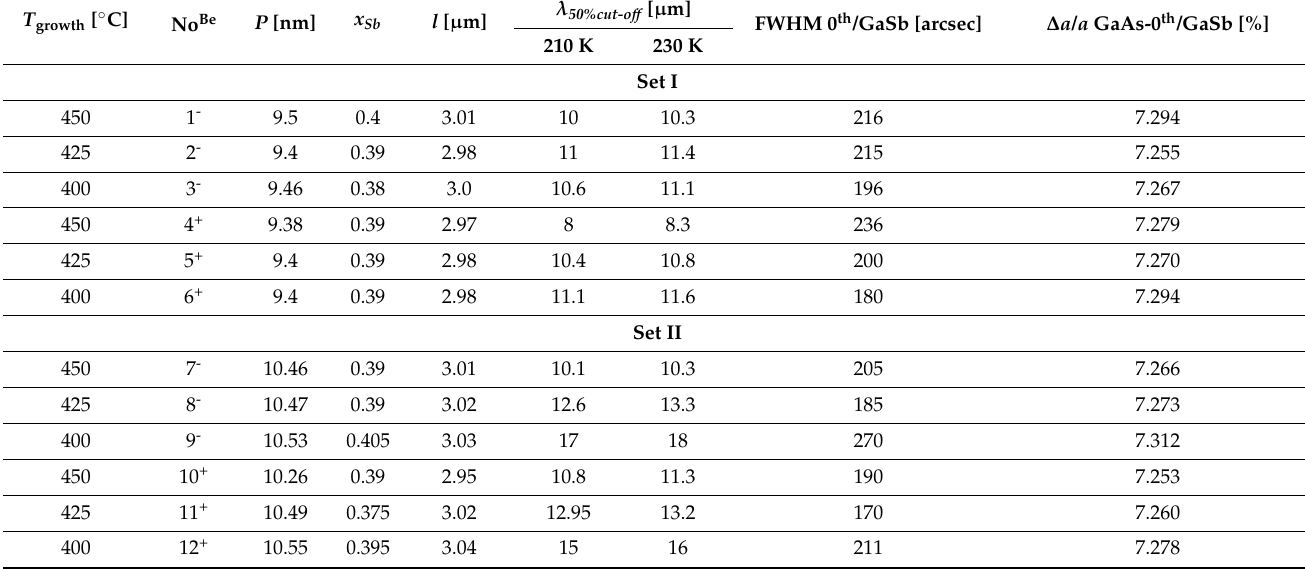
Table 1. MBE growth temperatures, analyzed T2SL structure properties (period, Sb composition), T2SLs’ active layer thickness, and measured λ 50%cut-off at 210, 230 K, FWHM for 0 th -order HRXRD peaks of theT2SLs/GaSb and lattice mismatch ∆ a/a GaAs-0 th